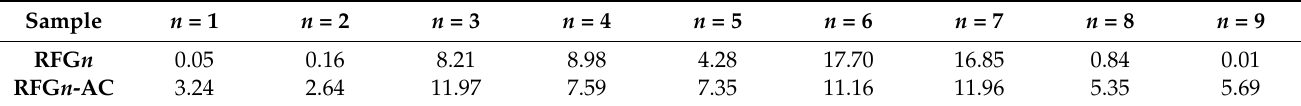
Table 4. N 2 gas adsorption capacity (mmol/g) at 77 K on RFGn and RFGn-AC samples.